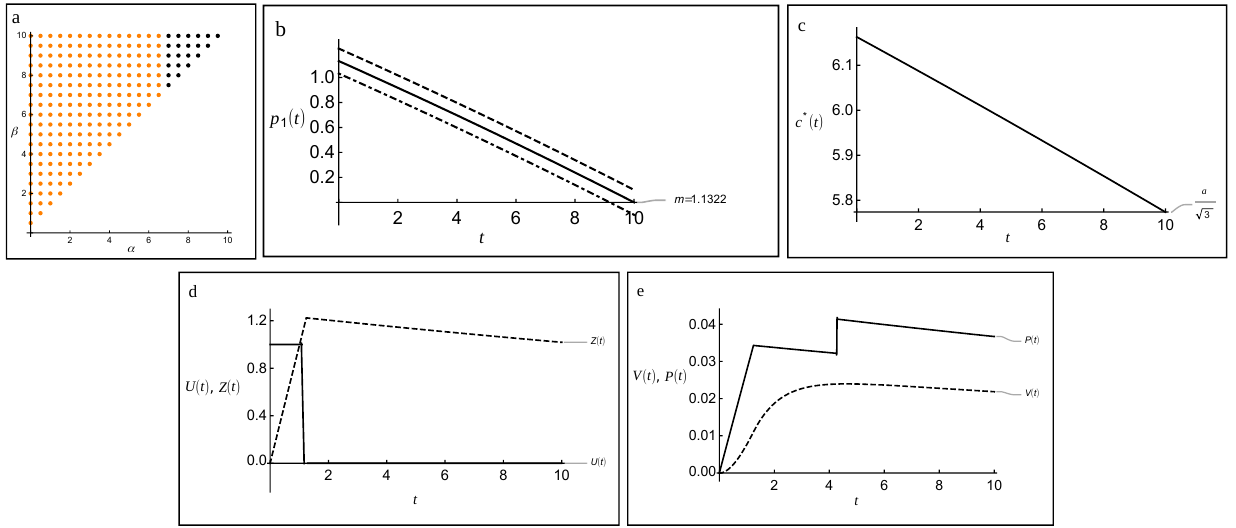
Figure 6. ( a ) Initial state; ( b ) dependence p 1 ( t ) ; graphs of the function p 1 ( t ) , and p 1 ( t ) ± 0.1 are given for clarity; ( c ) the price function depending on the time; ( d ) functions U , Z depending on the time; ( e ) functions V , P depending on the time. Values of the parameters of the dynamic system: a = 10, U 0 = 1, T = 10, k 1 =